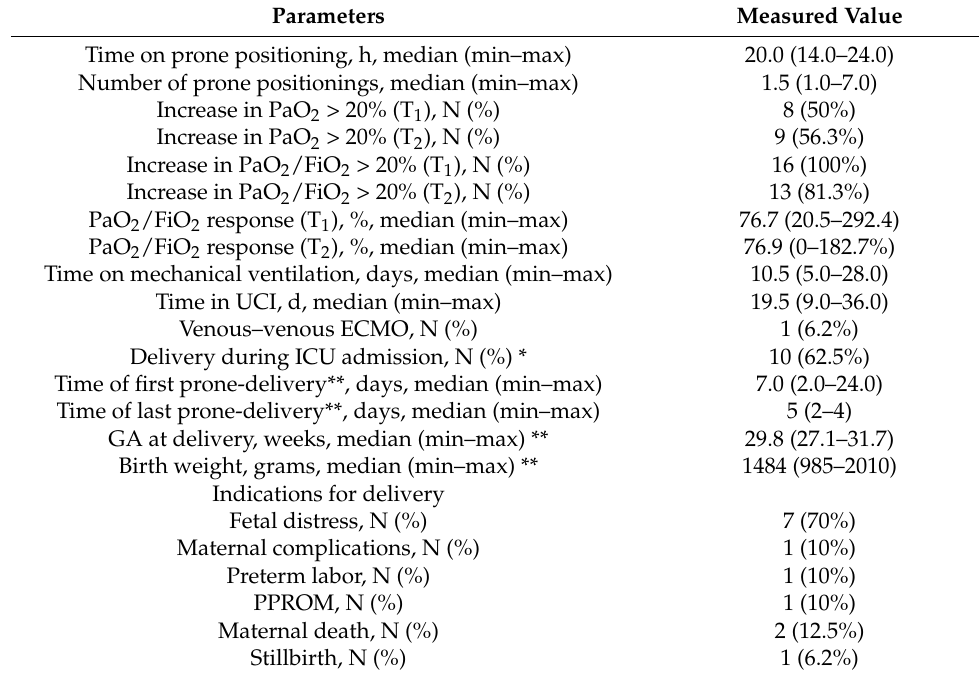
Table 2. Maternal and perinatal outcomes following prone